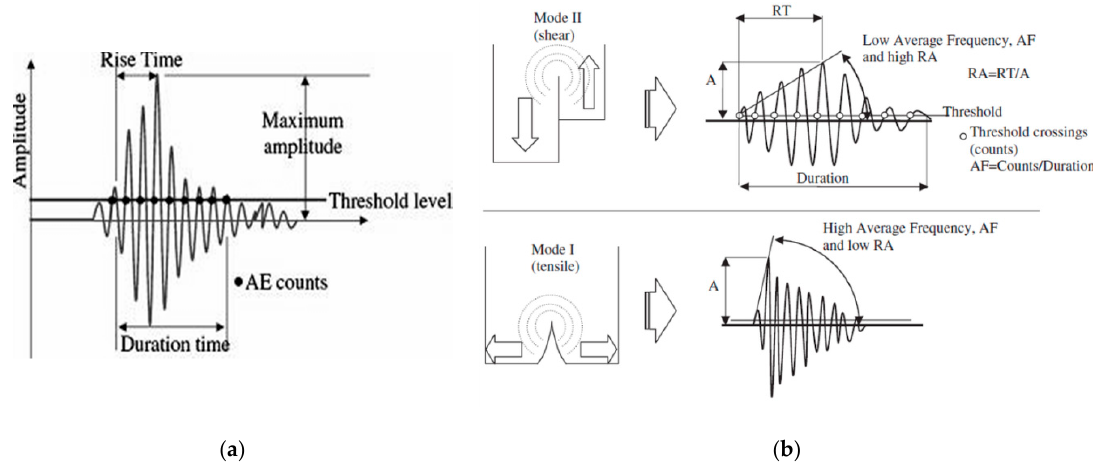
Figure 4. ( a ) Definition of major parameters in an acoustic emission (AE) waveform, ( b ) Types of AE waveforms relating to different fracture modes [66].